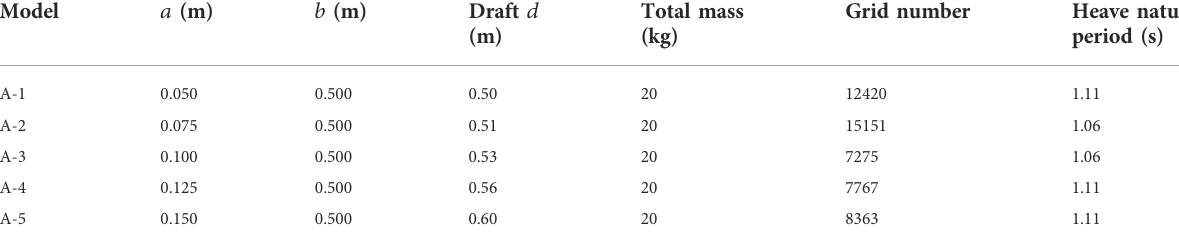
TABLE 1 Parameters of fi ve models with the chambers of different geometric sizes.